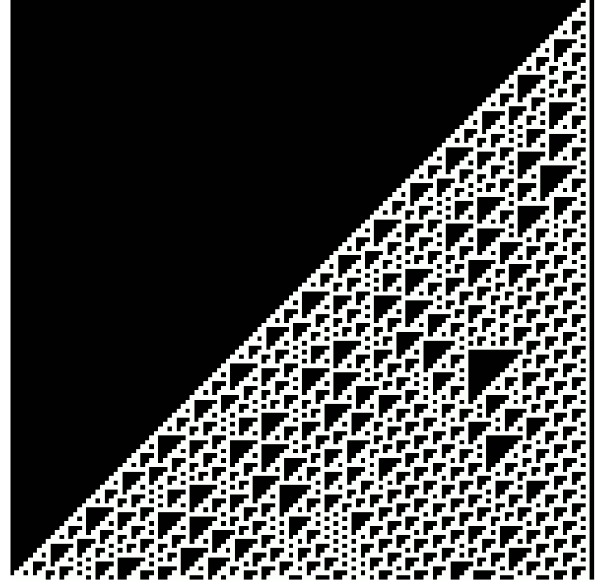
Figure 5. Temporal evolution of ECA 110. Each cell is represented by a column and time flows downwards, i.e. each row represents the state of the CA at successive time steps. Black cells represent ’0’ and white cells represent ’1’. The first row (initial state) consists of a single ’1’. The state of other rows depends on the state of the row above. It is not possible to compute a priori the state of the last row from the first row without computing all the intermediate